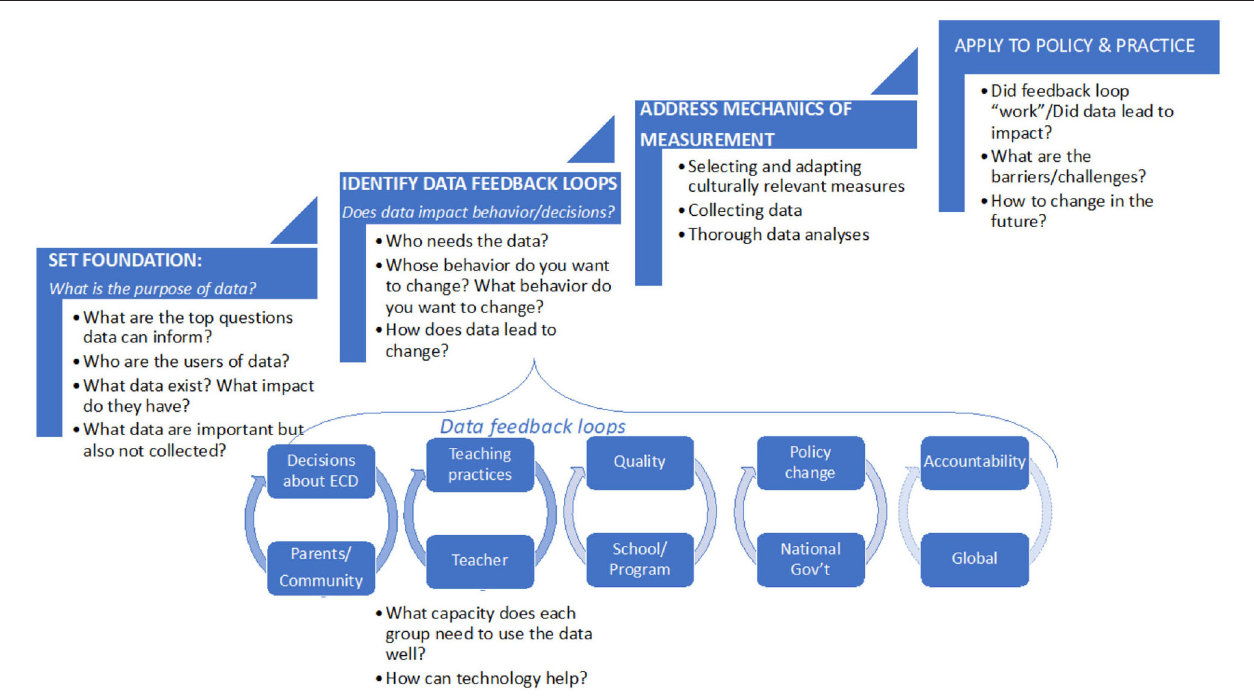
FIGURE 1 | Data for impact